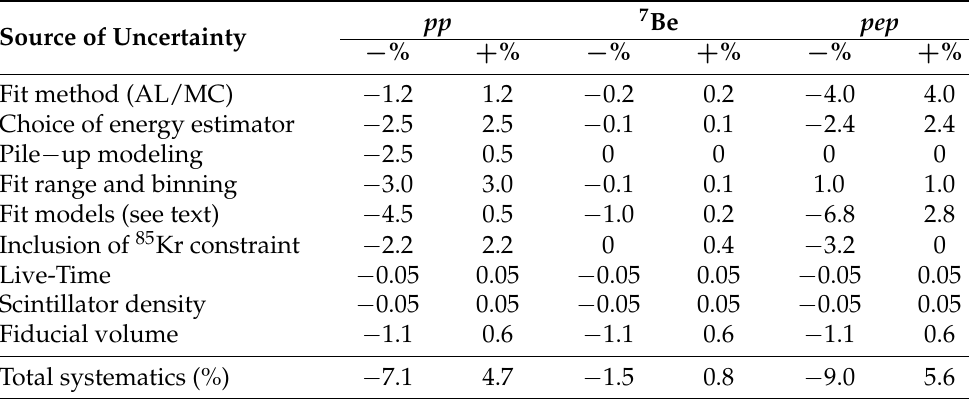
Table 6. Relevant sources of systematic uncertainties and their contribution to the measured interac- tion rates of pp chain solar neutrinos in the Borexino Phase II analysis in LER. The table is from [22]. Further details are discussed in the text.